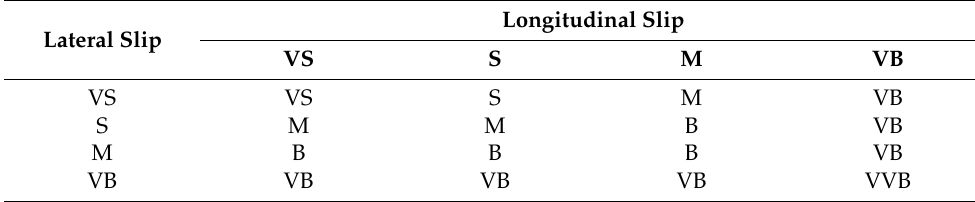
Table 2. Fuzzy inference rules.